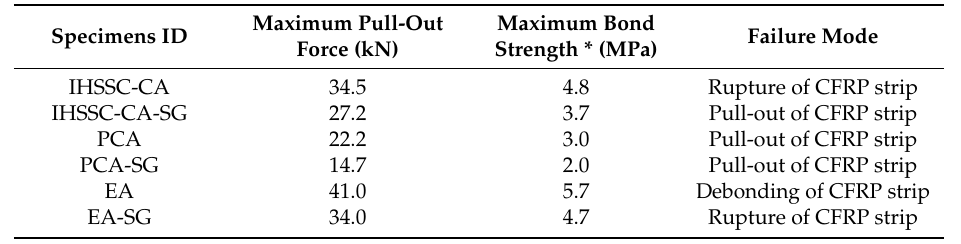
Table 2. Pull-out test results.